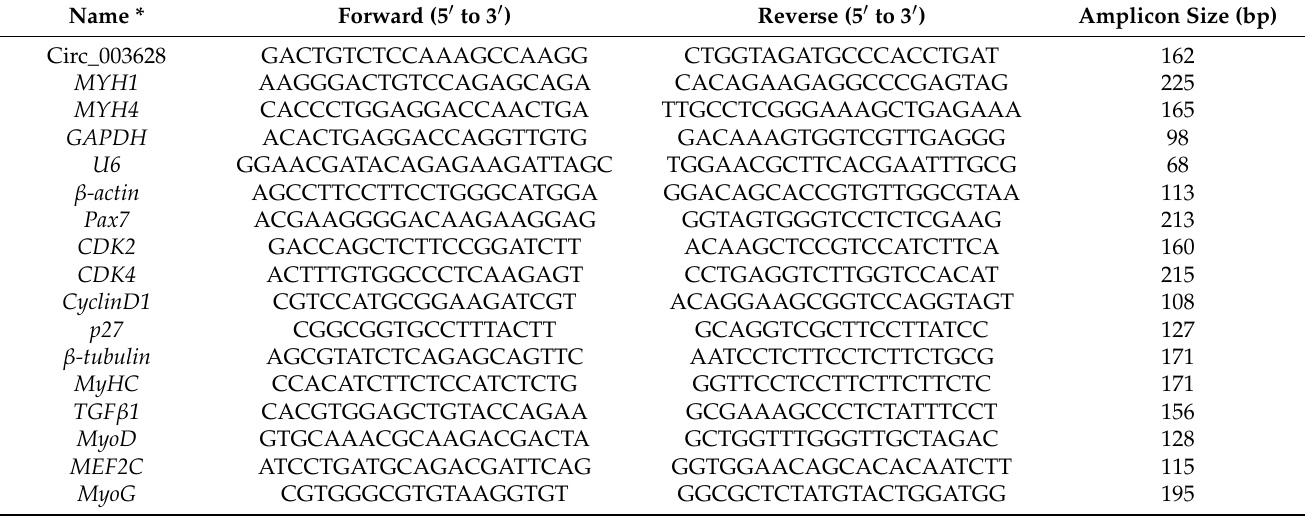
Table 1. Primer sequence information used for